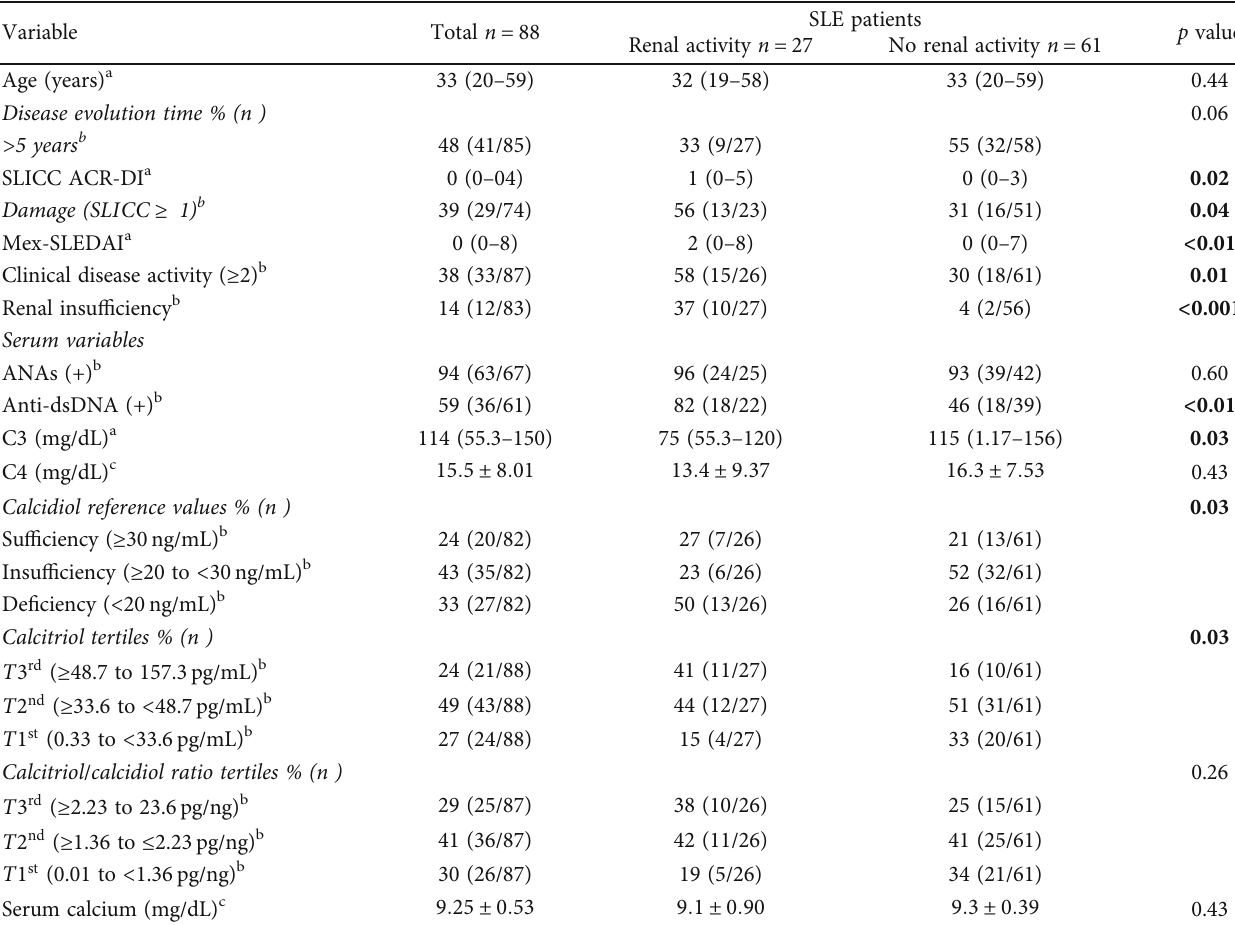
Table 2: Clinical characteristics by renal activity in SLE